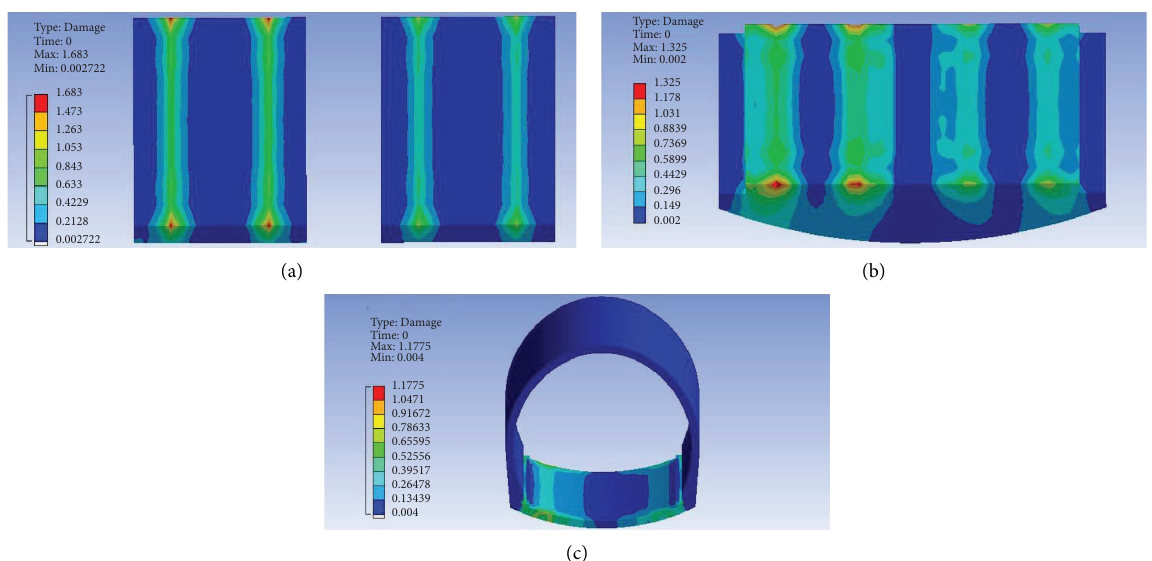
Figure 18: V damage distribution map of the bottom structure of the surrounding rock: (a) ballast bed structure; (b) flling structure; (c) invert